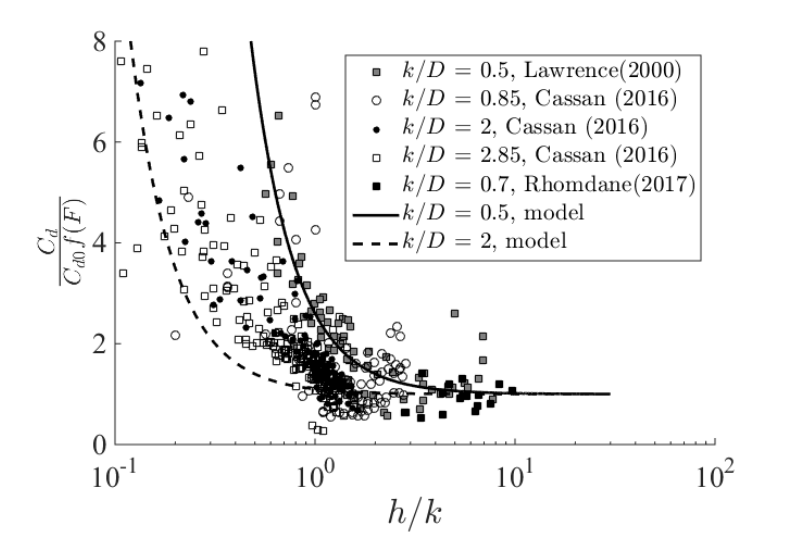
( h ∗ ) = C d from [20,24] compared with the proposed C d 0 f F ( F ) ∗